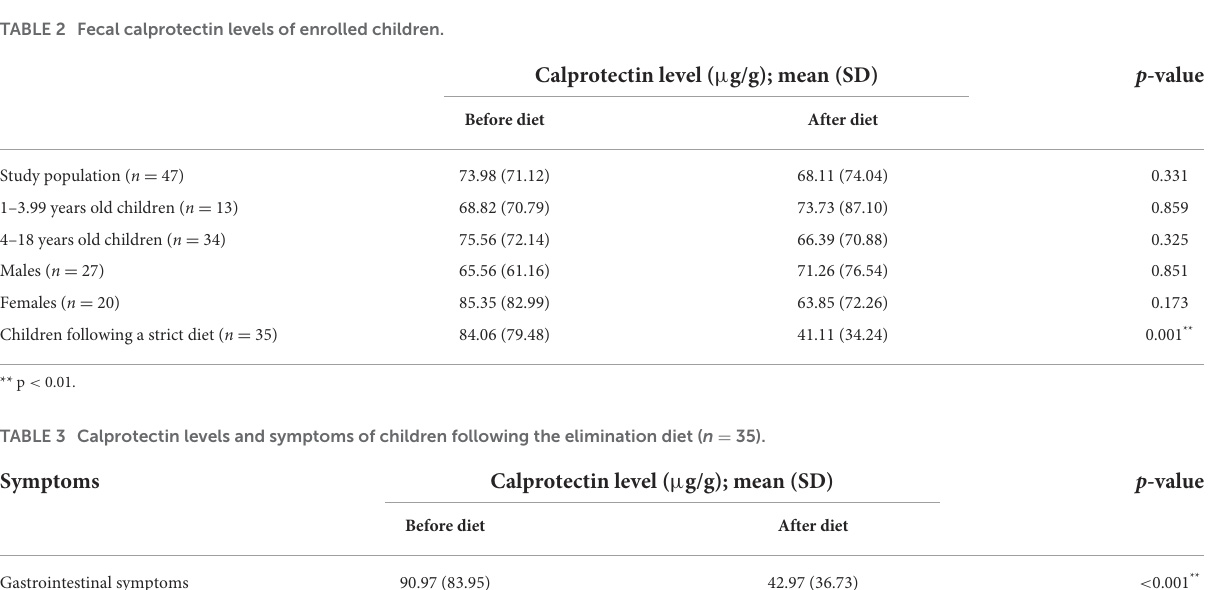
TABLE 2 Fecal calprotectin levels of enrolled children.